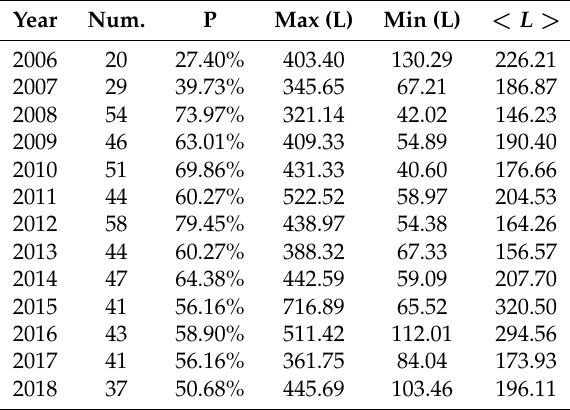
Table 1. Statistics of the identified warm